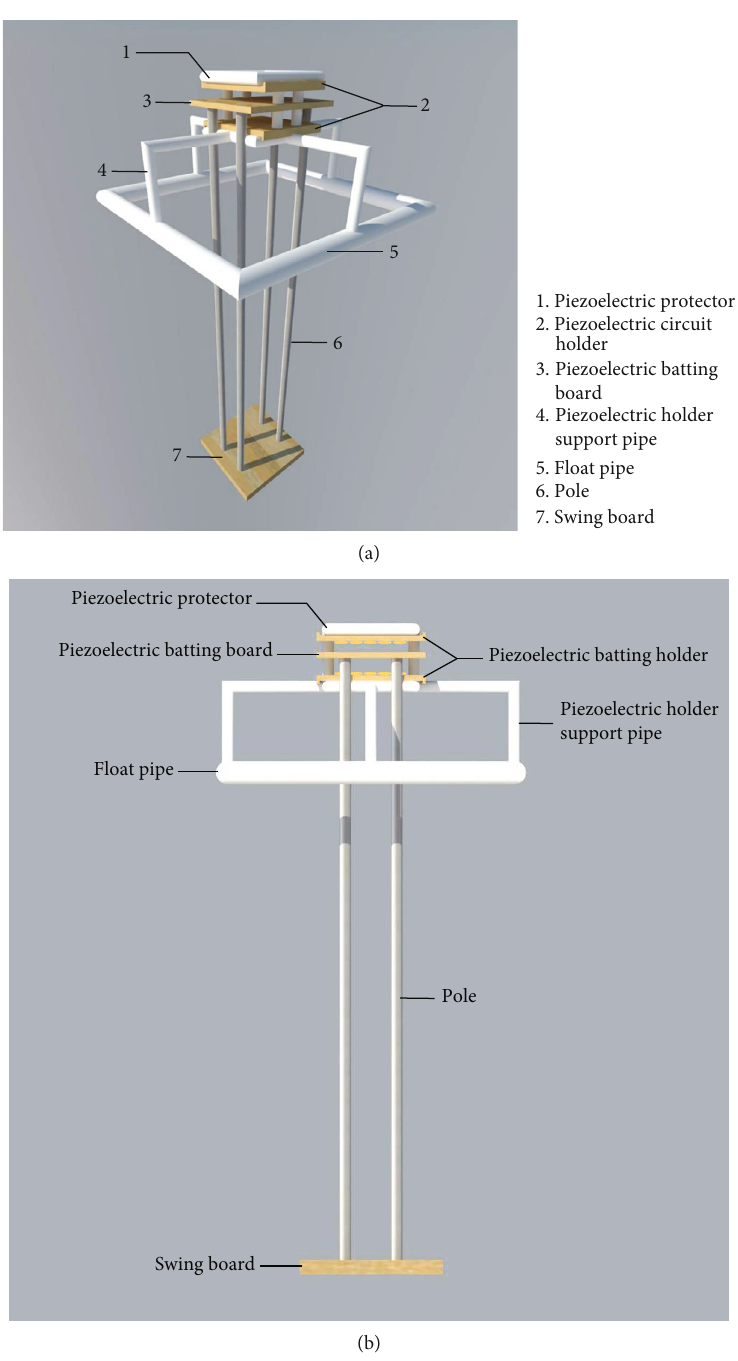
Figure 1: Cov-TOTal model: (a) side view; (b) front